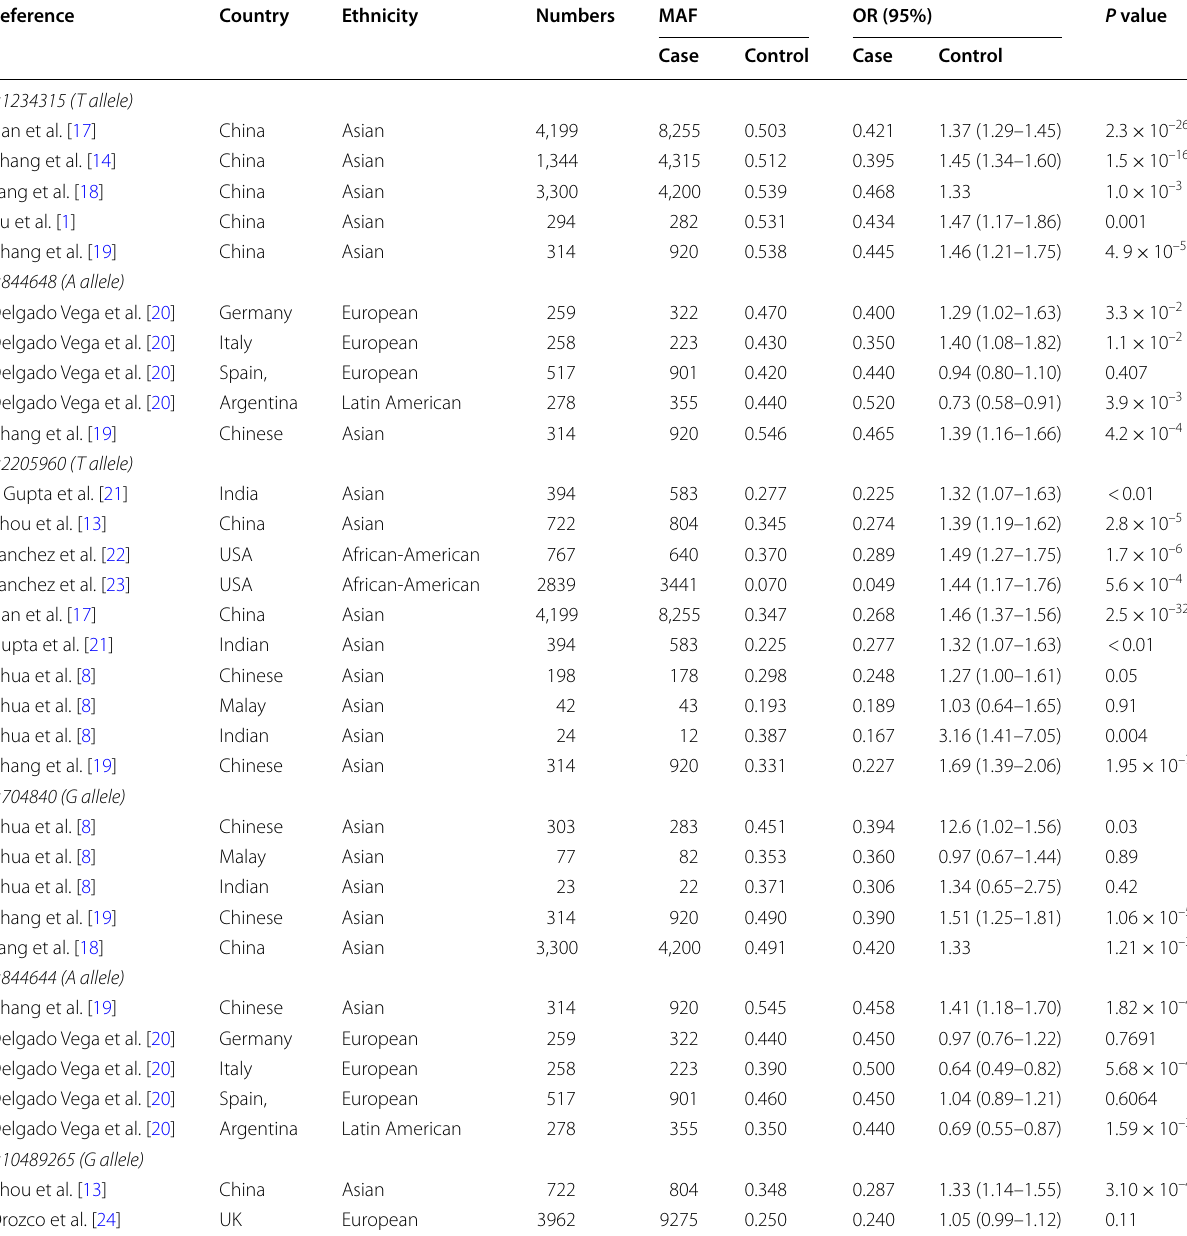
Table 2 Characteristics of the individual studies included in